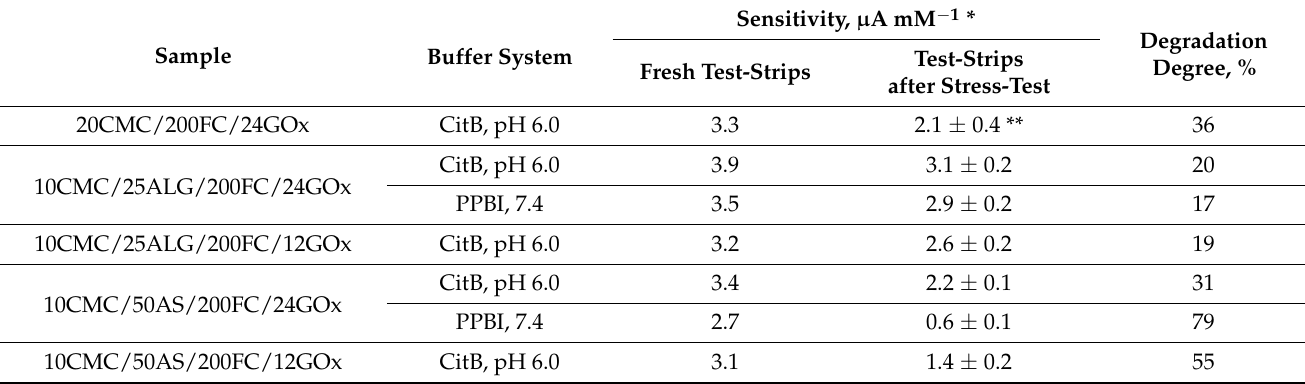
Table 2. The degradation of sensitivity of glucose test-strips during stress-test at 55 ◦